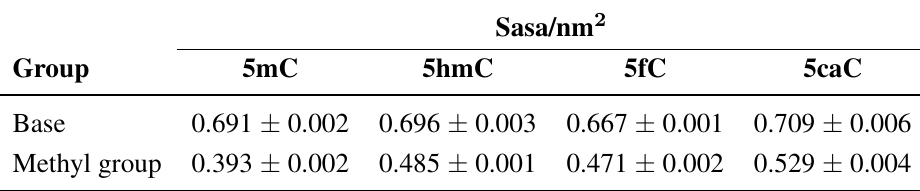
Table 2. Solvent accessible surface area (Sasa) of the base and the oxidized methyl group in 5-methyl-cytosine (5mC), 5-hydroxymethyl-cytosine (5hmC), 5-formyl-cytosine (5fC) and 5-carboxyl-cytosine (5caC). Sasa/nm 2